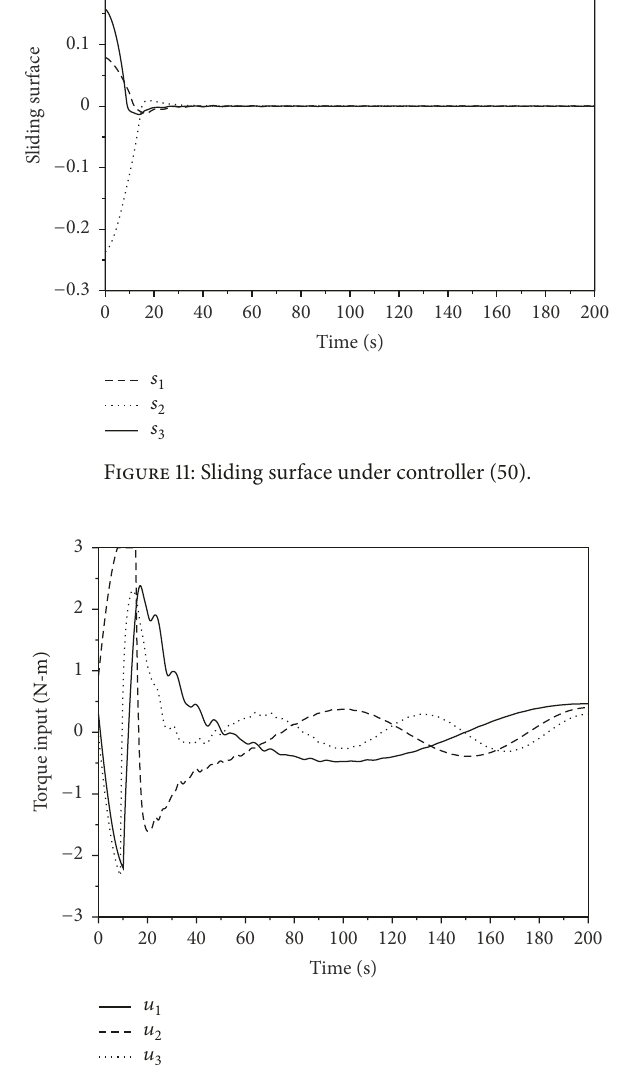
Figure 12: Control inputs under controller (50).